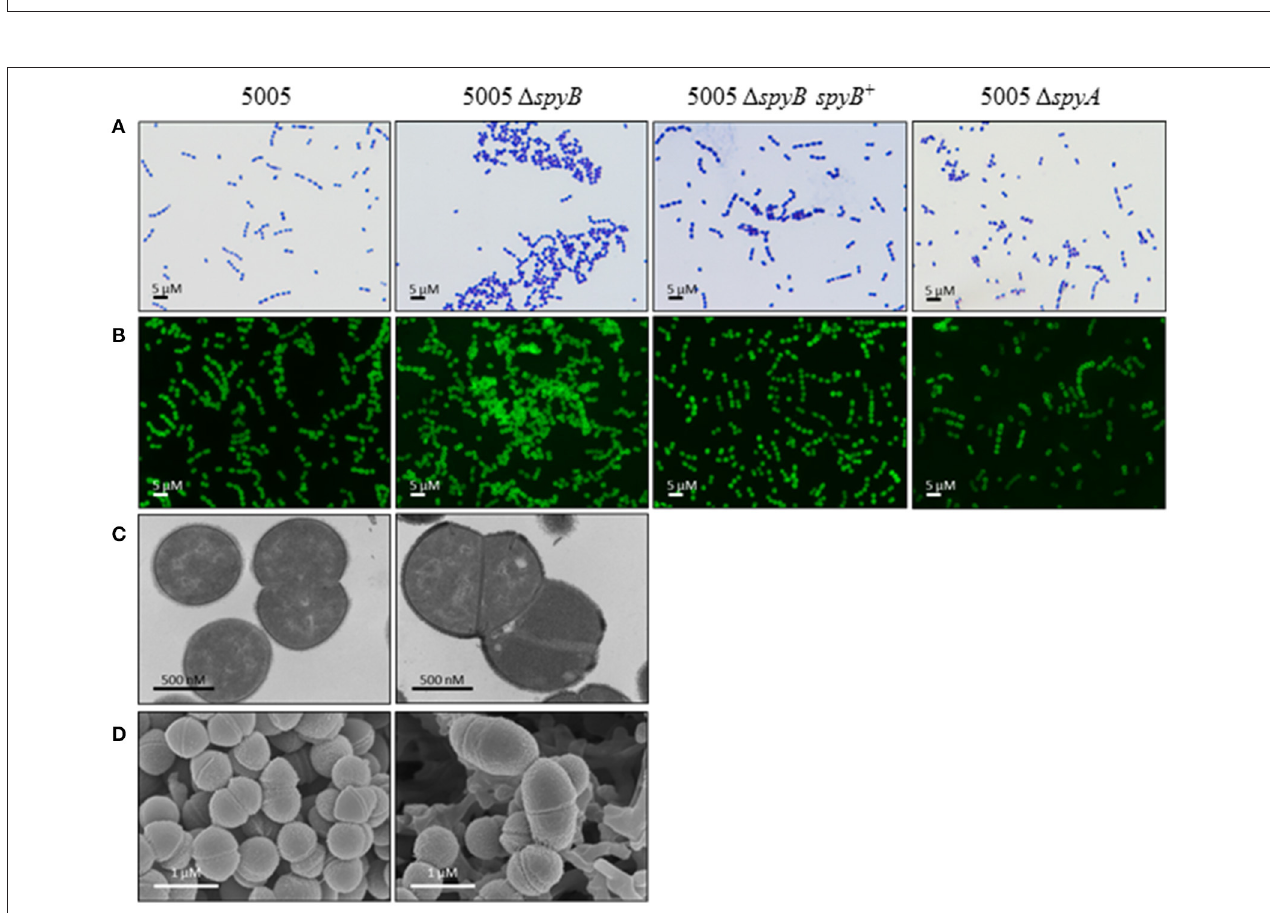
Frontiers in Cellular and Infection Microbiology | www.frontiersin.org